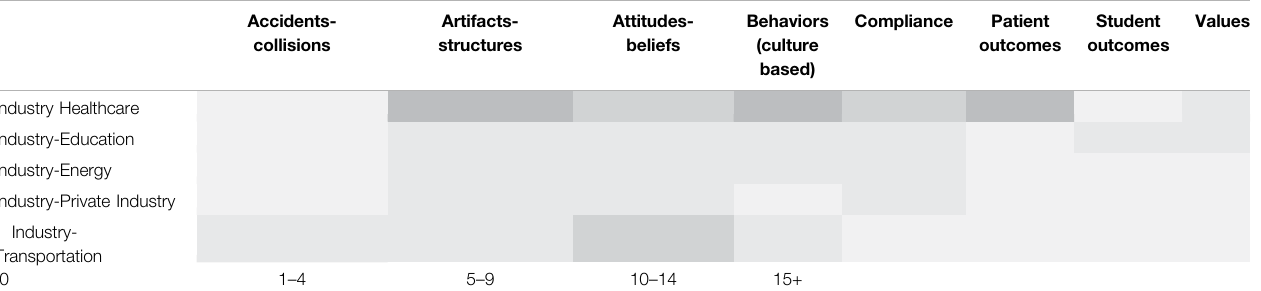
TABLE 5 | Matrix query results: Industry and outcome